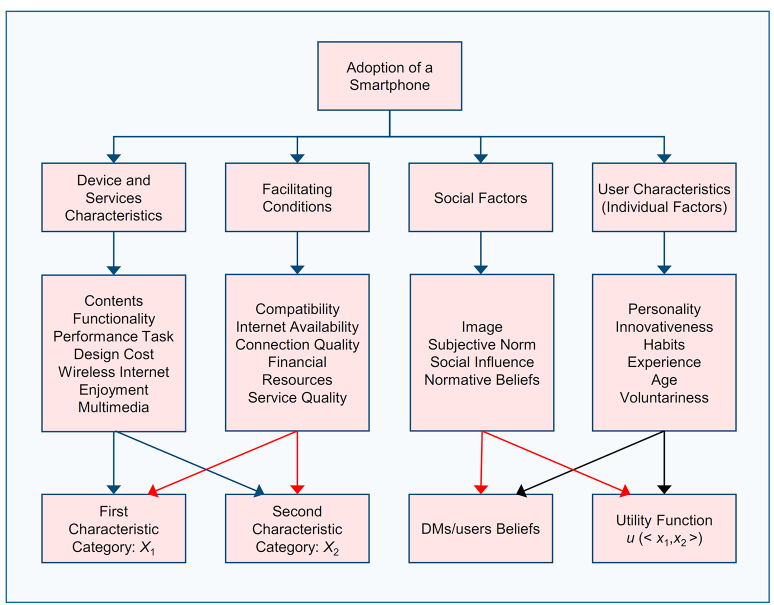
Figure 1. A taxonomy of the adoption factors for